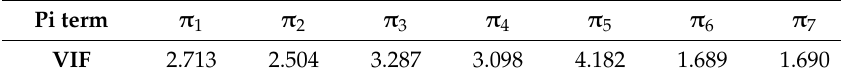
Table 4. Values of variance inflation factor (VIF).